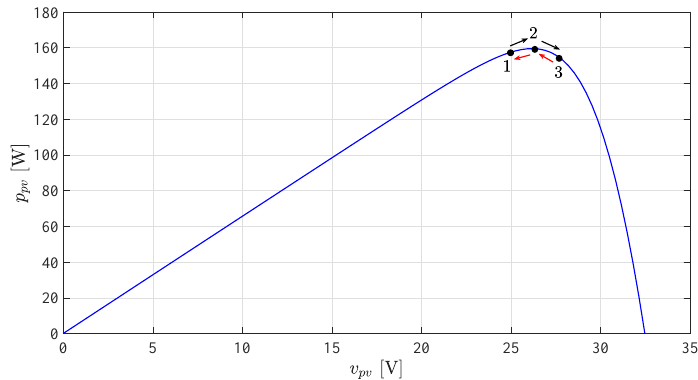
Figure 6. The behavior of the P&O method under three steps